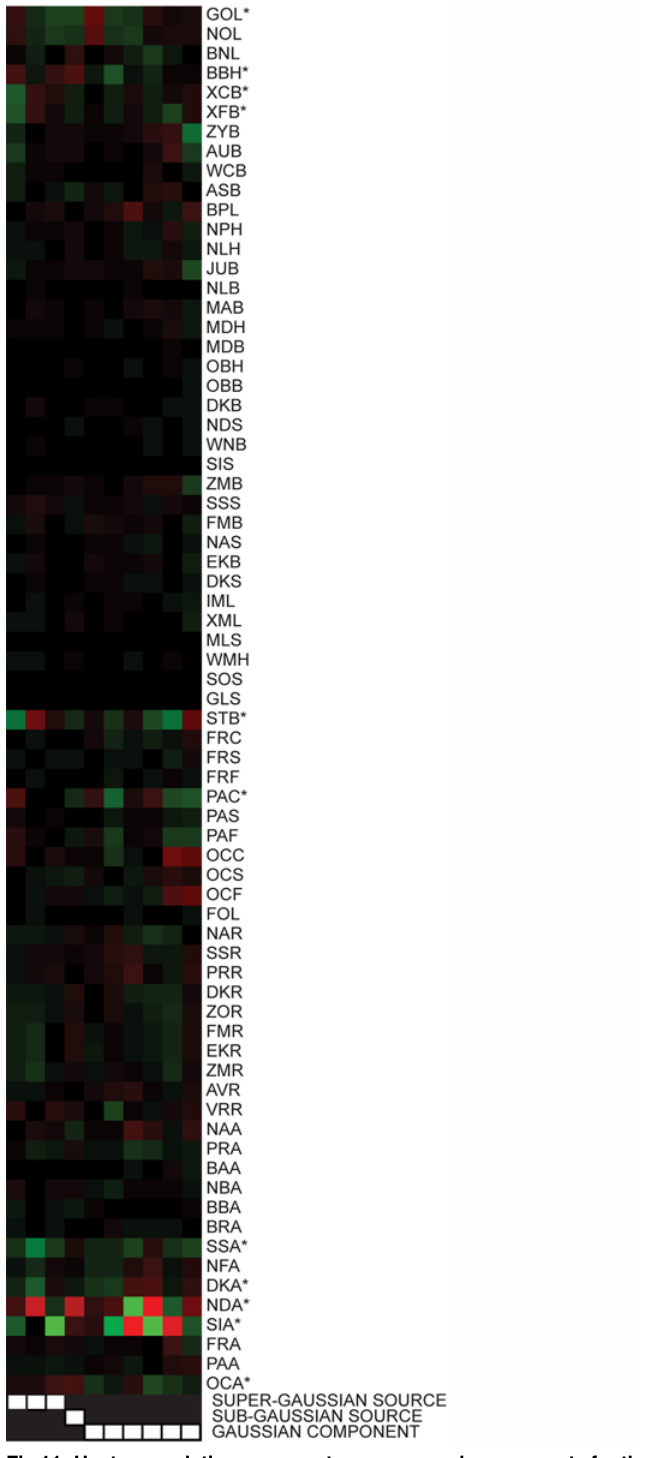
Fig 11. Heat map relating z-scores to sources and components for the craniometric data. Heat map intensities are derived from the best fitting model. Bright green values indicate that a higher (more positive) z-score contributes to a positive source or component score. Bright red values indicate that a higher (more positive) z-score contributes to a negative source or component score. The first four columns correspond sequentially to the sources shown in Figs. 6 – 9. The fifth column corresponds to the first principal